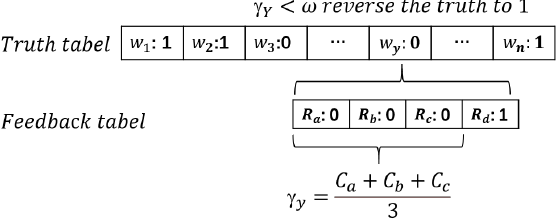
Figure 6. Reverse mechanism applied in situation